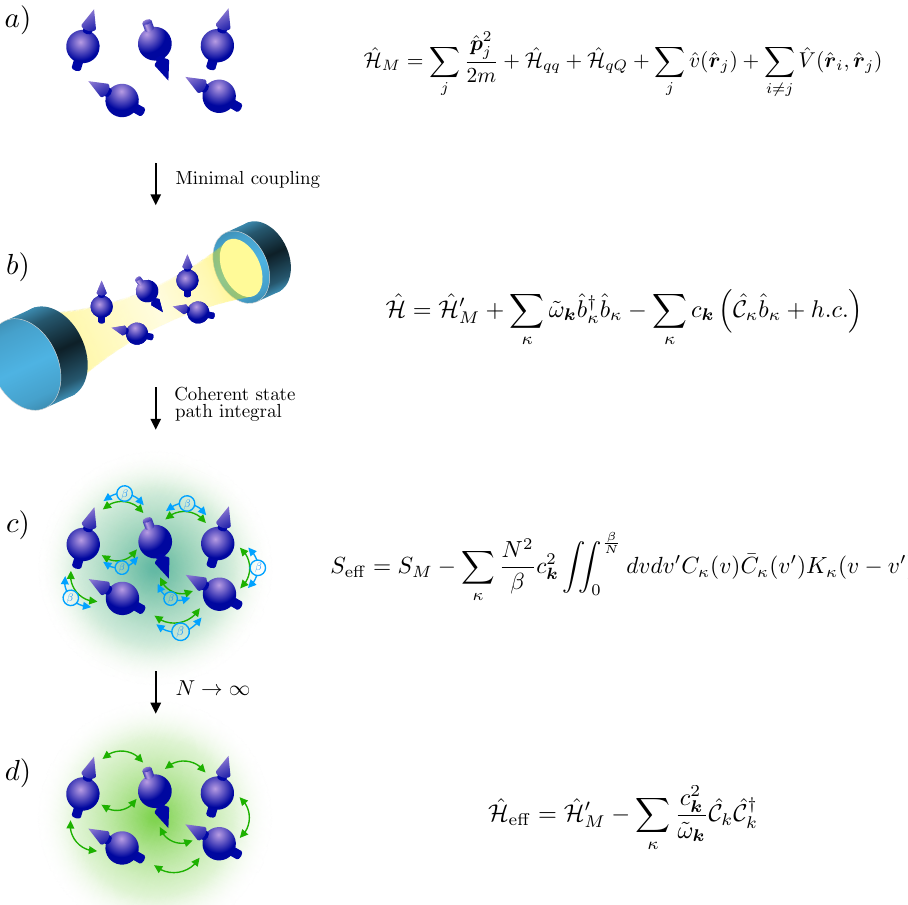
Figure 1: Schematic summary of the derivation of the effective theory. We begin by defining a general matter model in a). We accompany the illustration with an exam- ple Hamiltonian, but the theory extends to other models as well. The matter is then minimally coupled to an electromagnetic cavity in b). The corresponding Hamilto- nian describes a broad range of models, which are encoded in the coupling constants (cid:48) { c } and operators { ˆ } , and in ˆ . In c), the light degrees of freedom are non- κ k M C H perturbatively eliminated with a coherent state path integral, yielding a non-local action with effective matter-matter couplings. The non-local contributions vanish in the large- N limit and an exact effective Hamiltonian is obtained in